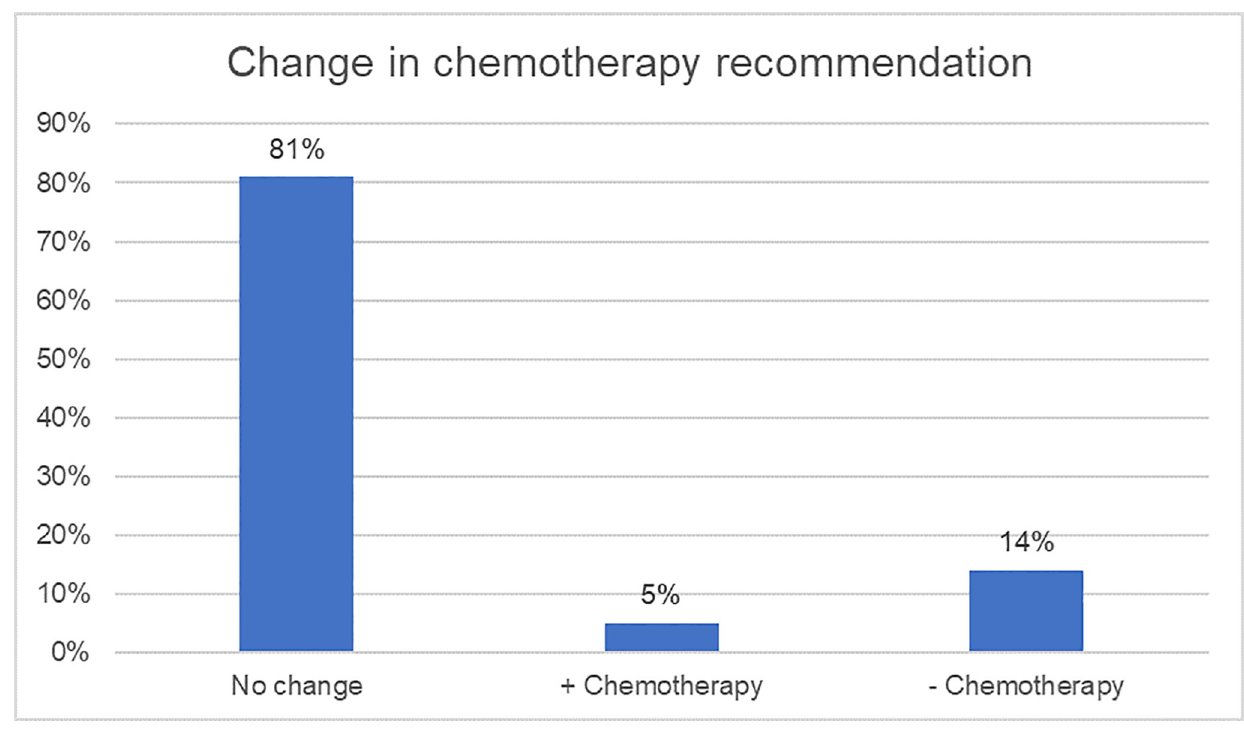
Fig 1. Change in chemotherapy